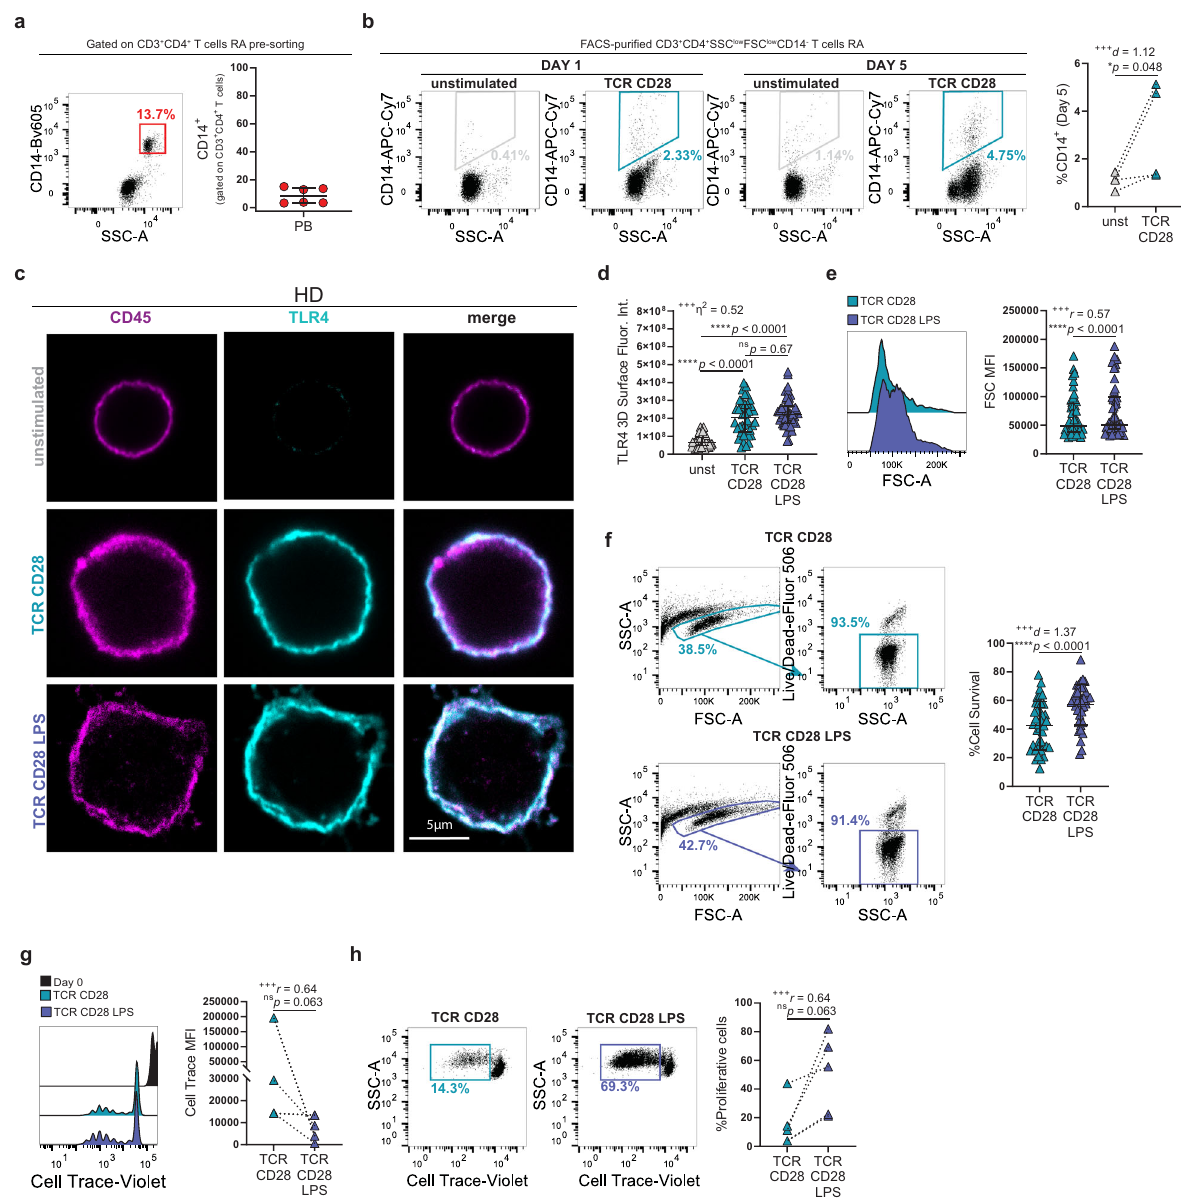
Fig. 3 TCR and CD28 stimulation lead to CD14 and TLR4 upregulation in RA patients and in healthy donors. a Representative dot plot and cumulative graph of the frequency of CD14 expression in CD3 + CD4 + T cells of peripheral blood of RA patients ( n = 6 RA patients). b Representative dot plot and cumulative graph of CD14 expression by FACS-puri fi ed CD14 − CD3 + CD4 + SSC low FSC low T cells from RA patients after 1 and 5 days with and without α CD3 and α CD28 stimulation ( n = 4 RA patients). c – d Confocal microscopy of FACS-puri fi ed CD3 + CD4 + SSC low FSC low T cells from healthy donors (HD) that were either left unstimulated (unst) or were stimulated with α TCR and α CD28 for 5 days in the presence or absence of LPS. c Cells were surface labeled for CD45 and TLR4 and analyzed by 3D confocal microscopy. Bar, 5 μ m. d Cumulative graphs of 3D TLR4 fl uorescence ( n = 143 cells from four different HD, n = 43 cells unstimulated, n = 40 cells TCR CD28 and n = 50 cells TCR CD28 LPS conditions). e Representative histogram and cumulative plot of FSC MFI of CD4 + T cells from HD stimulated for 5 days with α TCR and α CD28 in the presence or absence of LPS ( n = 30 HD, 53 independent experiments). f Representative dot plots and cumulative graph of the frequency of viable cells CD4 + T from HD stimulated for 5 days with α TCR and α CD28 in the presence or absence of LPS and labeled with cell viability dye ( n = 30 HD, 39 independent experiments). g Representative histogram and cumulative plot of cell trace MFI of CD4 + T cells from HD stimulated for 5 days with α TCR and α CD28 in the presence or absence of LPS ( n = 5 HD). h Representative dot plots and cumulative graph of proliferative CD4 + T cells from HD stimulated for 5 days with α TCR and α CD28 in the presence or absence of LPS ( n = 5 HD). Data are presented as mean ± SD, for parametric statistical tests, or median ± IQR, for non-parametric statistical tests. Sample normality distribution was tested by using D ’ Agostino & Pearson normality test ( n > 6) or Shapiro – Wilk normality test ( n ≤ 6). P values **** p ≤ 0.0001, *** p ≤ 0.001, ** p ≤ 0.01, * p ≤ 0.05 were determined by ( b ) Ratio-paired t test; ( d ) Kruskal – Wallis test with posttest Dunn ’ s multiple comparisons; the p values are adjusted for multiple comparisons; ( e , g , h ) Wilcoxon matched-pairs rank test and ( f ) Paired t test. Effect size measures +++ high, ++ medium, + small were determined by ( b , f ) d – Cohen ’ s d; ( d ) η 2 – eta-squared and ( e , g , h ) r – correlation coef fi cient r